Question: What does this figure show? Answer in one sentence.
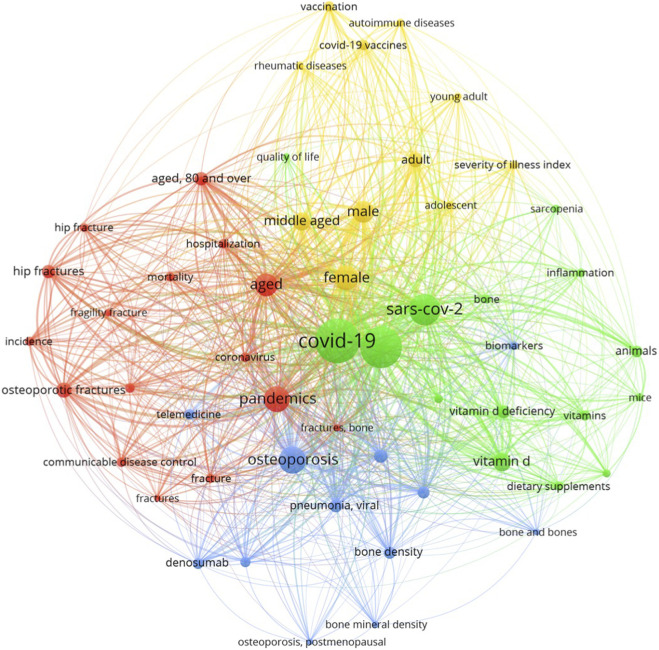
Answer: VOSviewer keyword co-occurrence map of COVID-19-related research. This network visualization illustrates the co-occurrence relationships among keywords in COVID-19-and bone- related literature. The bibliometric dataset was obtained from PubMed using the search terms “COVID-19” and “bone”, and the map was generated by the authors using VOSviewer 1.6.20 41 . Each node represents a keyword, with node size corresponding to its frequency and edge thickness representing co-occurrence strength. Colors indicate distinct clusters, reflecting thematic groupings within the research field.